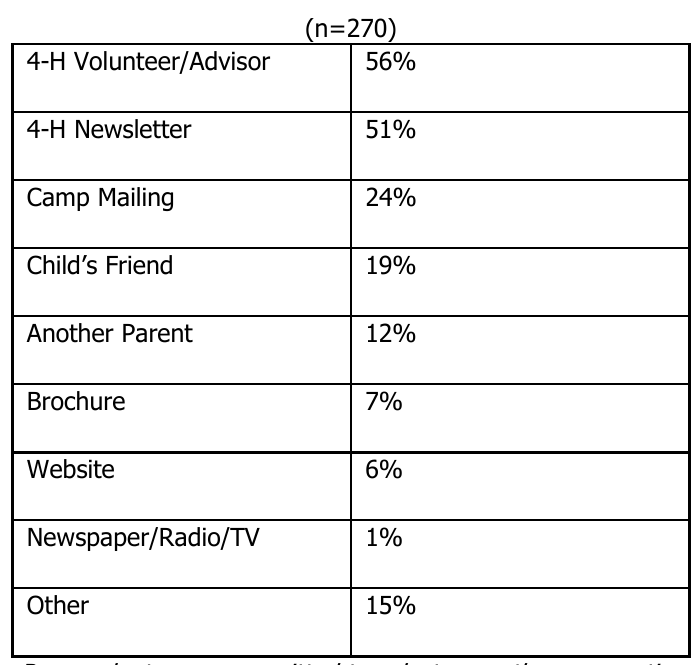
How Did your Child Learn about 4-H